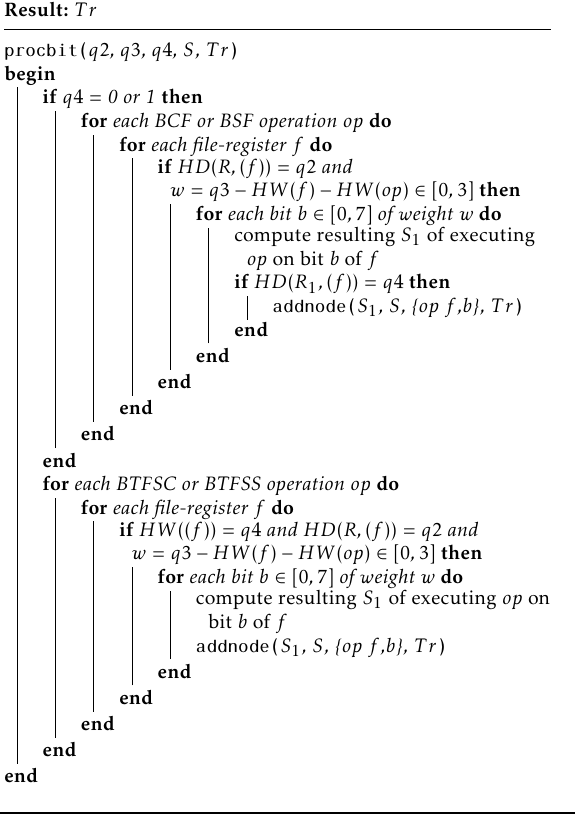
Algorithm 3: procbyte : Find all byte-oriented Algorithm 4: procbit : Find all bit-oriented